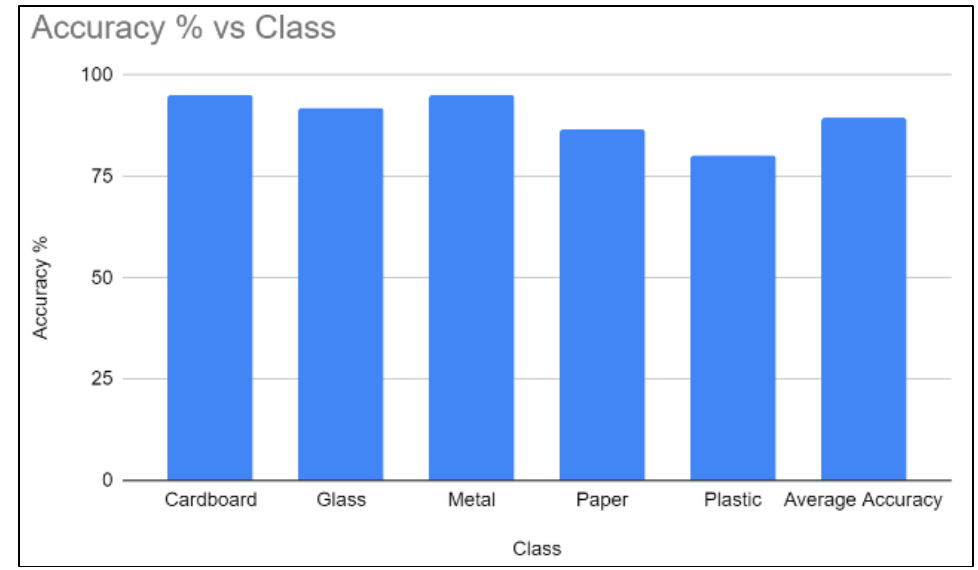
Figure 16. Accuracy graph for each of the six